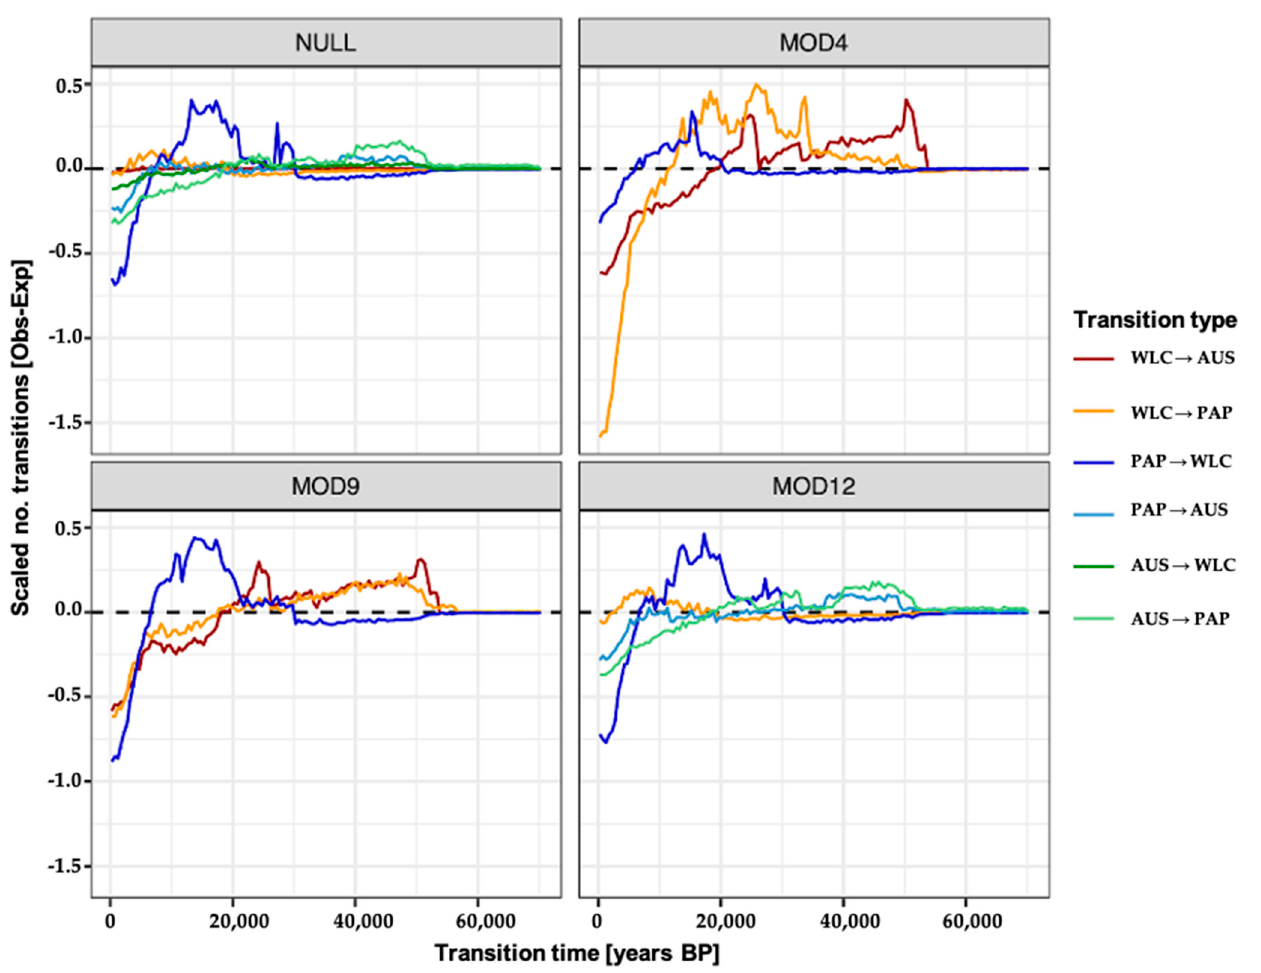
Figure 5. Estimated migration rates across Wallacea, New Guinea, and Australia. Distribution of the mean migration rates across each region across time for the four best-performing BayesTraits models. For each model, migration rates were estimated from 1000 SIMMAP stochastic mappings, with each migration event comprising a single simulated state transition occurring on a branch of the consensus BEAST tree. Transition rate matrices and ancestral node states were derived from BayesTraits (see Figure S4, Supplementary Materials, for other parameterisations). Migration rates are scaled to account for the expected number of migration events (see Section 2).